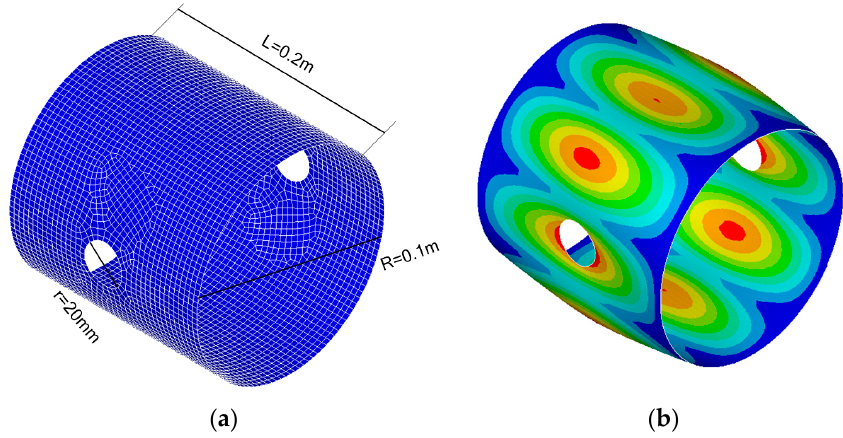
Figure 5. ( a ) Geometrical dimension and mesh of laminate cylindrical shell; ( b ) first order vibration model of (±45) 4 laminate.